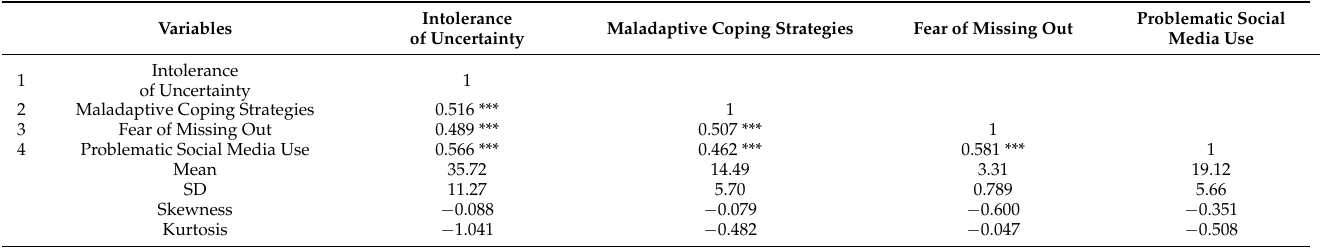
Table 1. Means, standard deviations, skewness, kurtosis, and correlations of the study variables ( n = 311).